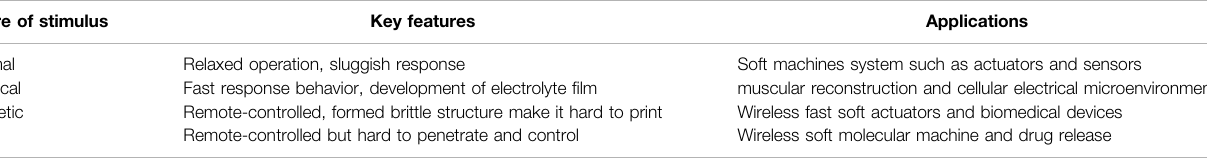
TABLE 2 | Hydrogels based on kind of stimulus-responsive behavior and key features with their main applications, respectively (Calvert, 2009). Copyright 2018, Biomimetic MDPI. Nature of